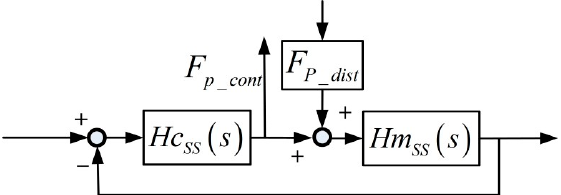
Figure 5. Relationship between position-dependent disturbance forces (PDDFs) and Short-Stroke (SS) controller forces.